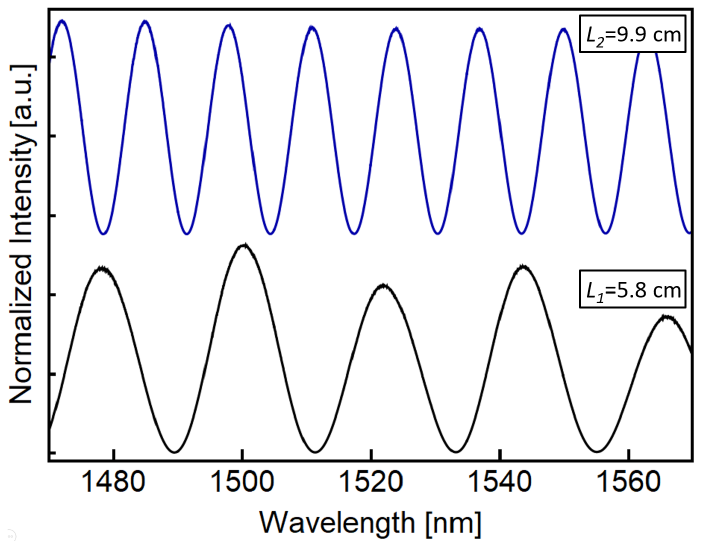
Figure 4. Individual transmitted spectral response of the SMF ‐ SCF ‐ SMF devices. Each SCF length is indicated with an increment in the wavelength frequency as we increase the SCF length. indicated with an increment in the wavelength frequency as we increase the SCF